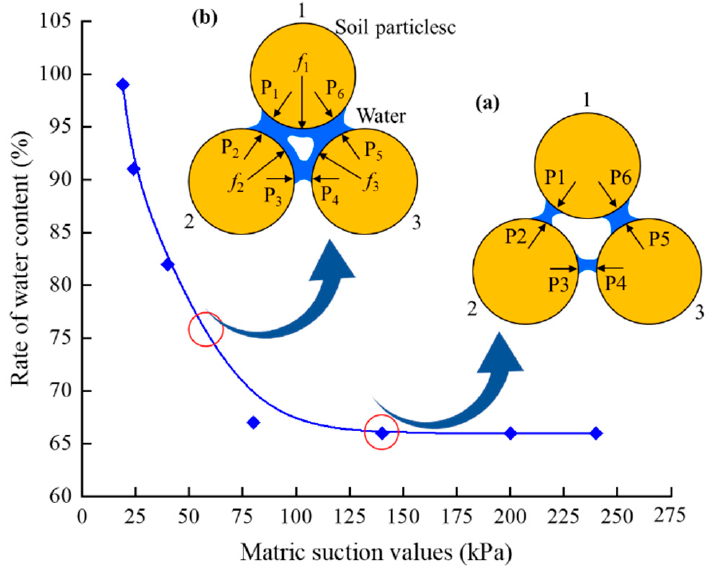
Figure 6. The relationships between rate of water content and matric suction of silty clay [50]. ( a ) low water content; ( b ) high water content.